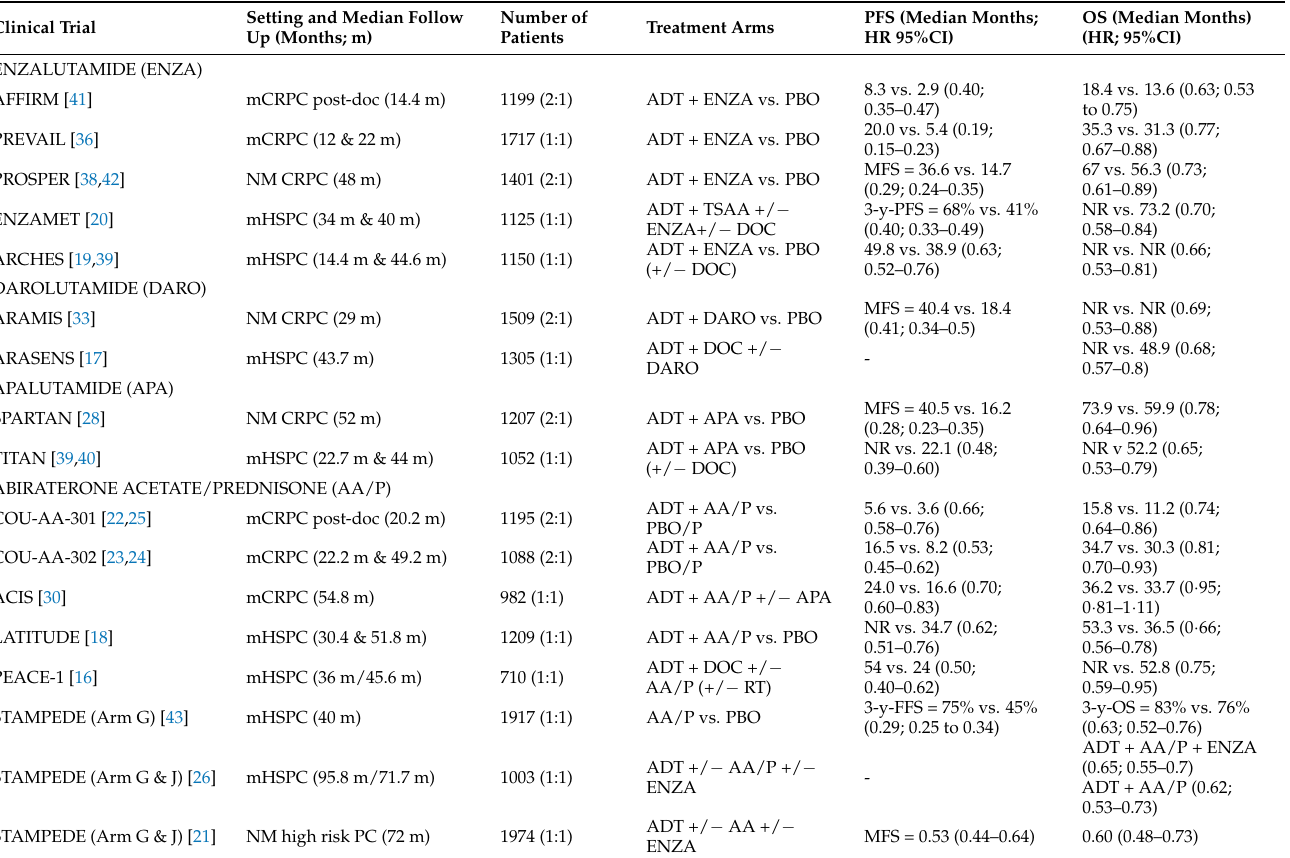
Table 1. Main clinical trials evaluating the role of currently approved androgen receptor signaling inhibitors